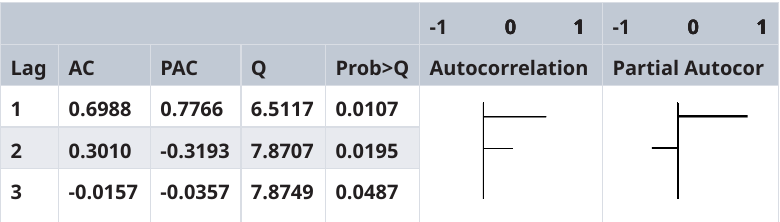
Table 2. Time lags of sales growth of soft drinks in Saudi Arabia 2010–2020, as analysed by